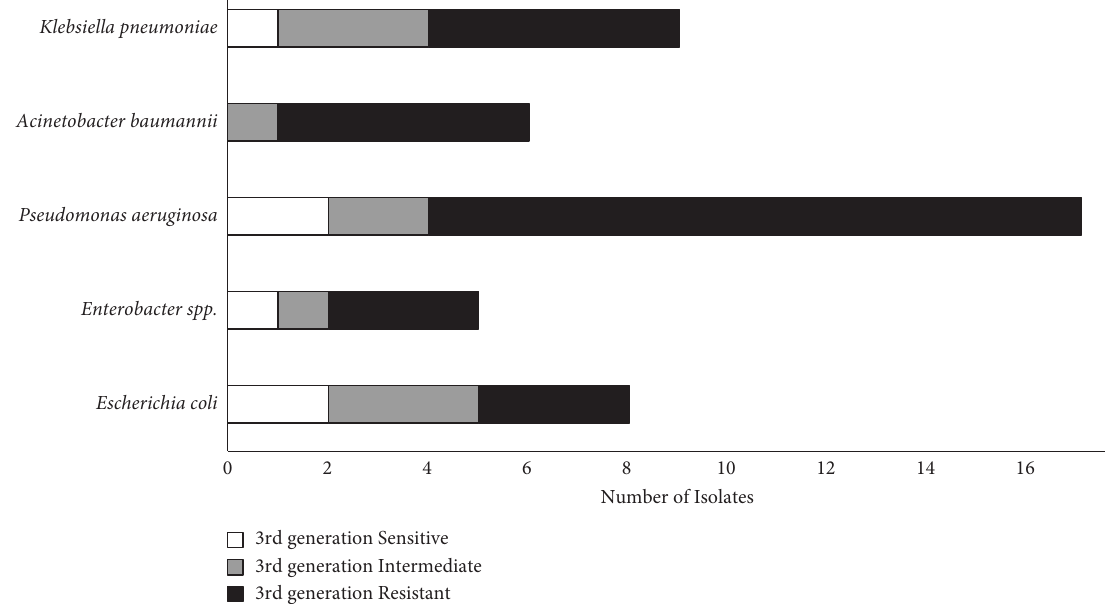
Figure 3: Resistance patterns of isolated gram-negative ESKAPE Pathogens. 3rd generation cephalosporins: sensitive, intermediate, and resistant were determined by CLSI